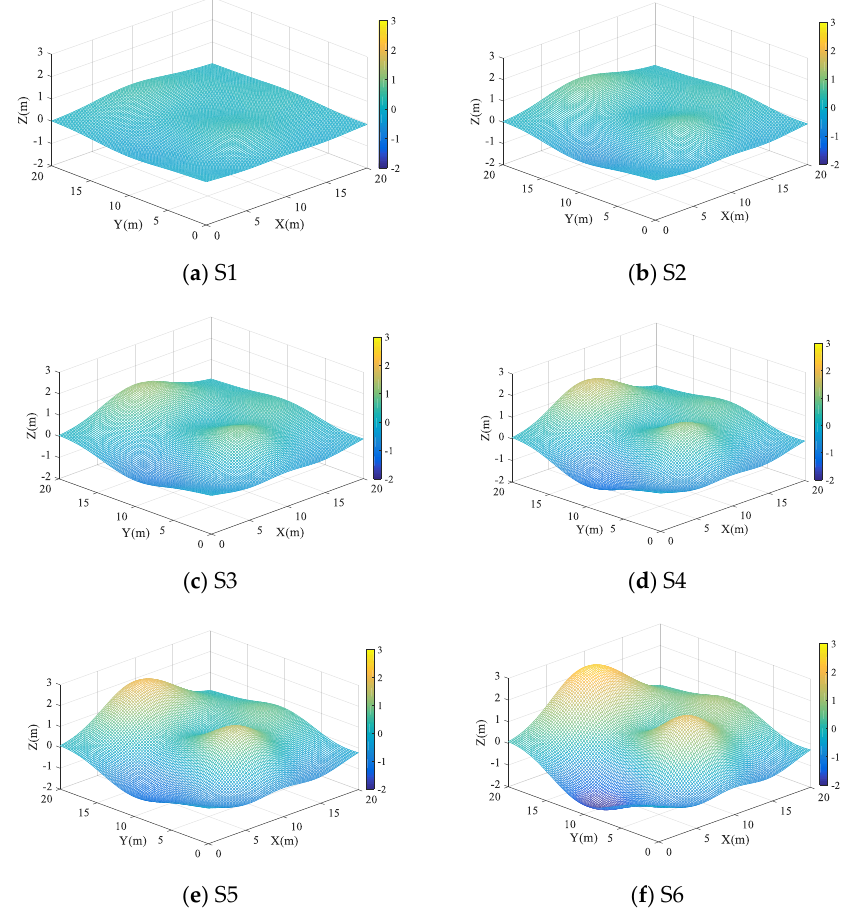
Figure 8. Simulated wave surfaces with different complexities.